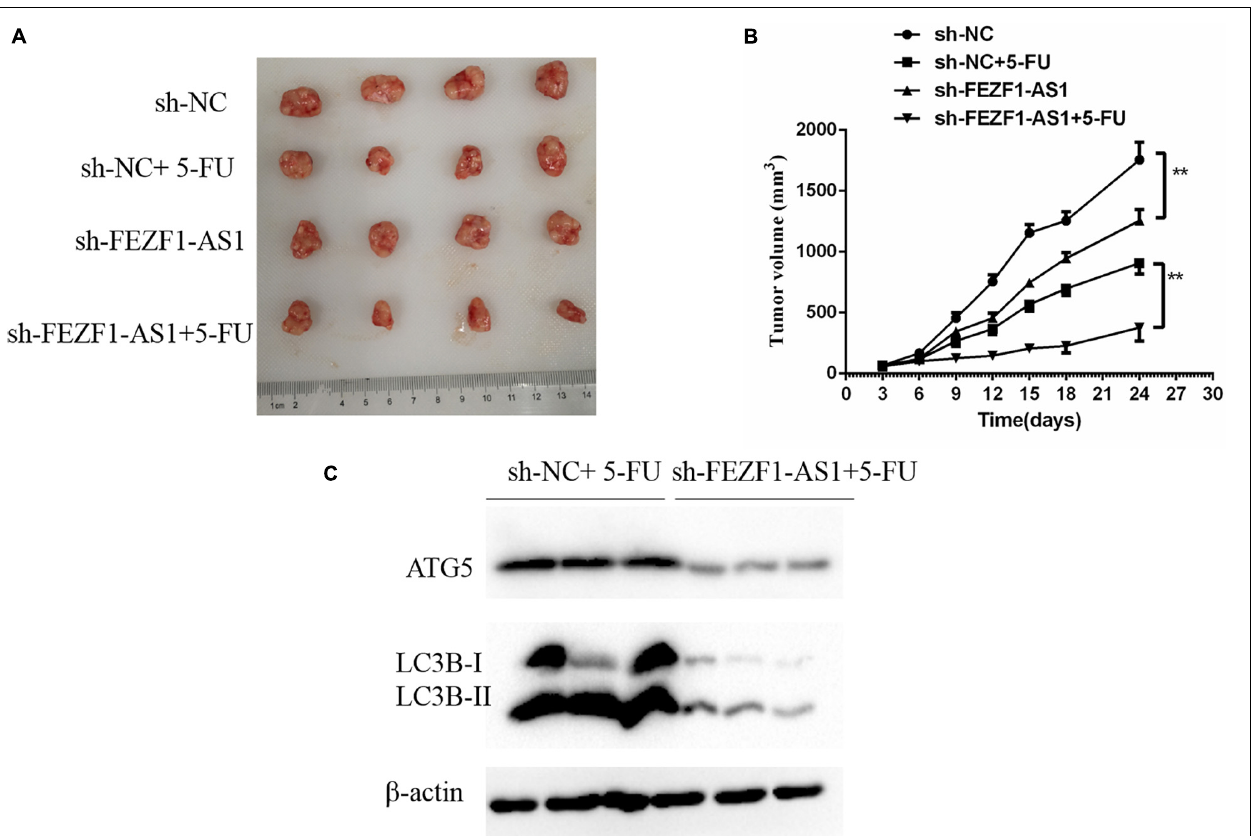
FIGURE 6 | Knockdown of FEZF1-AS1 increased 5-FU sensitivity in tumors in vivo . (A) Representative images of xenograft tumors. (B) Tumor volume of mice. (C) Western blot analysis of LC3 and ATG5 protein levels in sh-NC-SGC7901 and sh-FEZF1-AS1-SGC7901 mice treated with 5-FU. Data were presented as the means ± SD from 4 tumor samples. ** P <